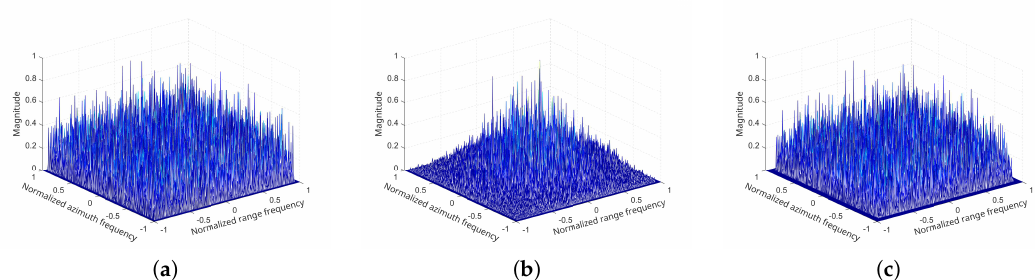
Figure 4. Normalized power spectra of simulated SLC (VV channel). ( a ) Uncorrelated speckle, ρ ACF = 0.0020; ( b ) correlated speckle, ρ ACF = 0.1886; ( c ) decorrelated speckle, ρ ACF =